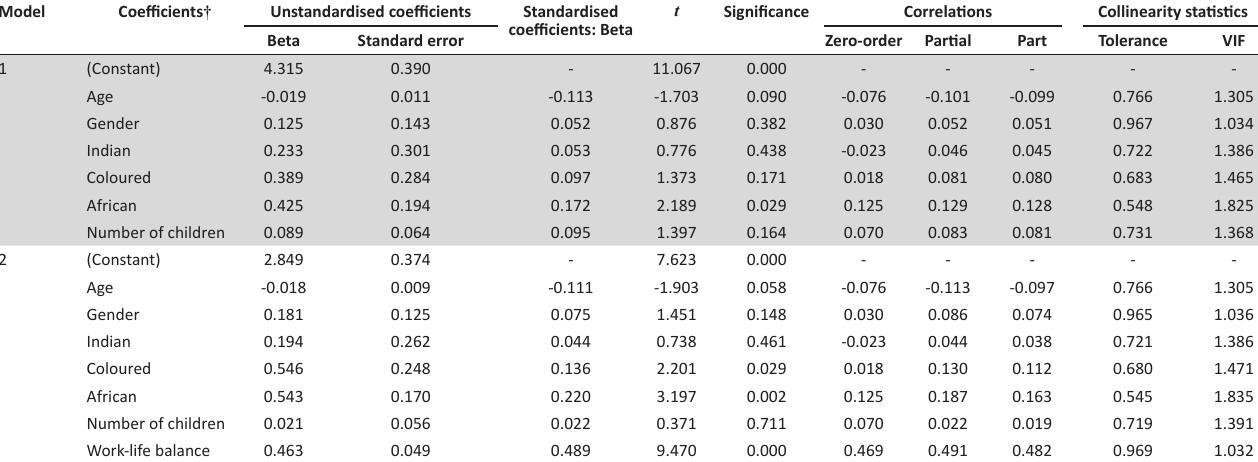
TABLE 3: Regression coefficients for Hypothesis 1. Model